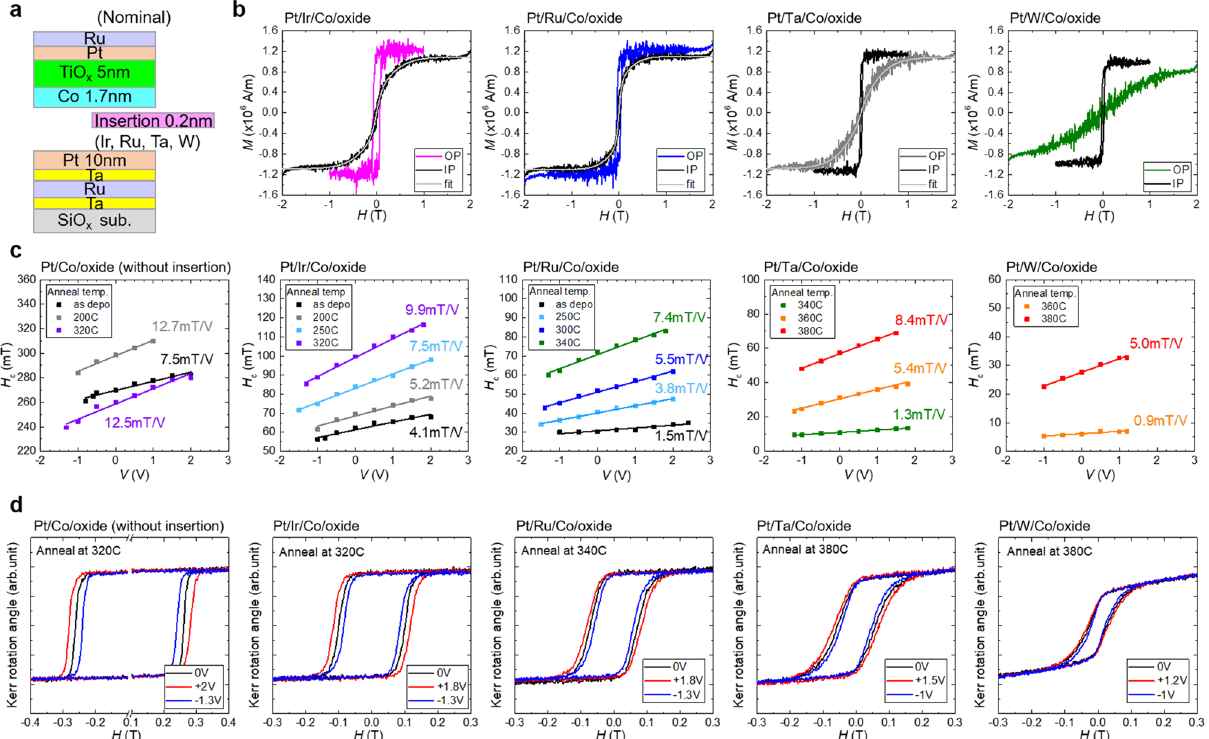
Figure 3. ( a ) Schematics of nominal sample structure (SiO x sub./Ta (5 nm)/Ru (10 nm)/Ta (5 nm)/Pt (10 nm)/ heavy metal insertion layer (0.2 nm)/Co (1.7 nm)/TiO x (5 nm)/Pt (5 nm)/Ru (2 nm)). ( b ) Perpendicular (colored lines) and in-plane (black lines) magnetization curves of the heavy mental-inserted samples. The fitting curve used for evaluating magnetic anisotropy energy is also shown by light gray lines. ( c ) Bias-voltage- dependence of H c of the samples at different annealing temperatures. ( d ) Bias-voltage-dependent perpendicular magnetization curves of the samples at a representative annealing